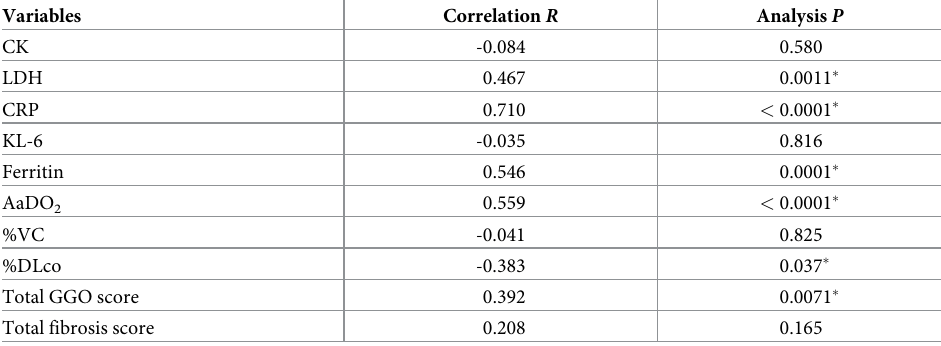
Table 3. Correlation between serum LRG levels and other disease activity indicators of DM-IP. Variables Correlation R Analysis P CK